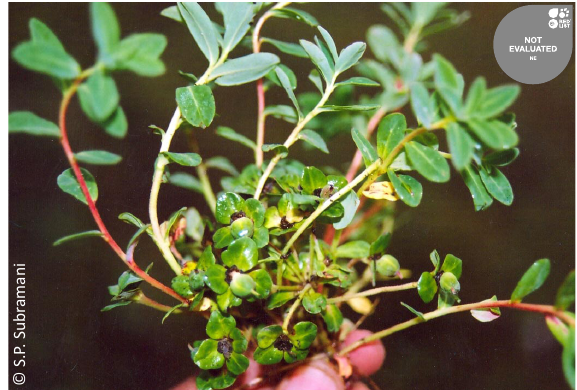
Image 22. Euphorbia stracheyi Boiss.